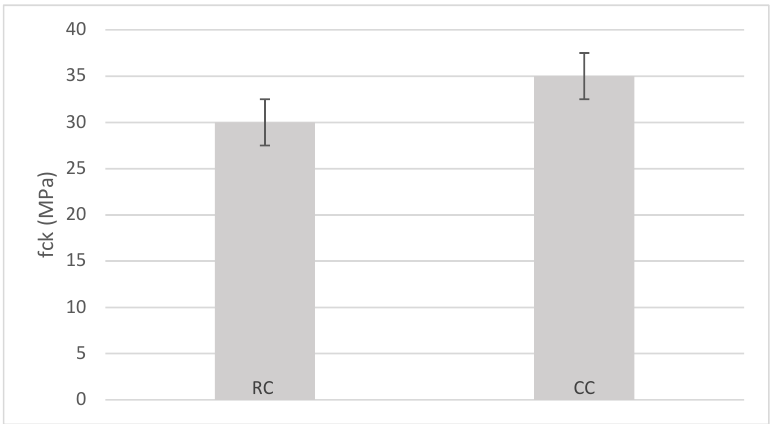
Figure 4. Characteristic compressive strength at 28 days (MPa) for recycled concrete ( RC ) and control concrete ( CC ).